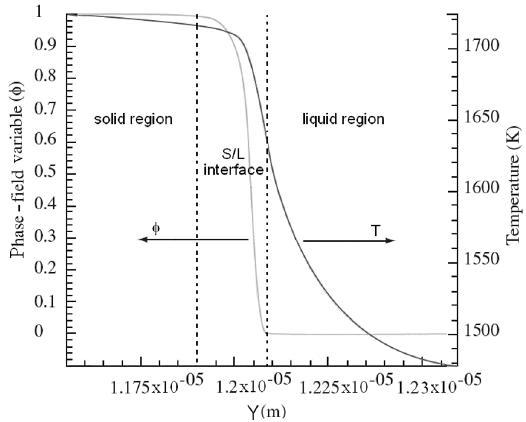
Figure 3. Temperature and phase-field variable profiles across solid, interface and liquid